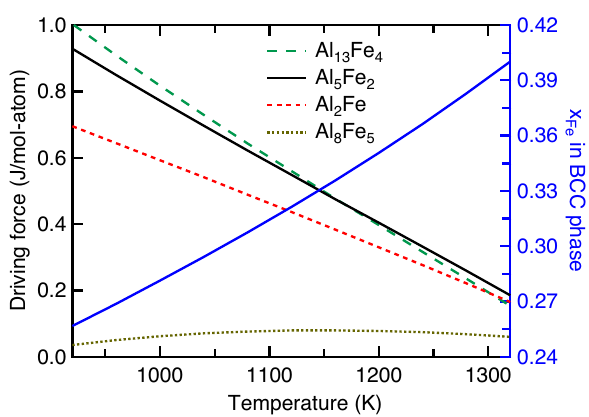
Figure 6. Thermodynamic driving forces of Al–Fe IMCs as a function of temperature ( T = 920–1320 K) as well as the associated mole fraction of Fe ( x Fe = 0.26–0.40) along the metastable solidus line as shown in Fig. 1. Here, the Al–Fe thermodynamic properties were modelled by Sundman et al. 9